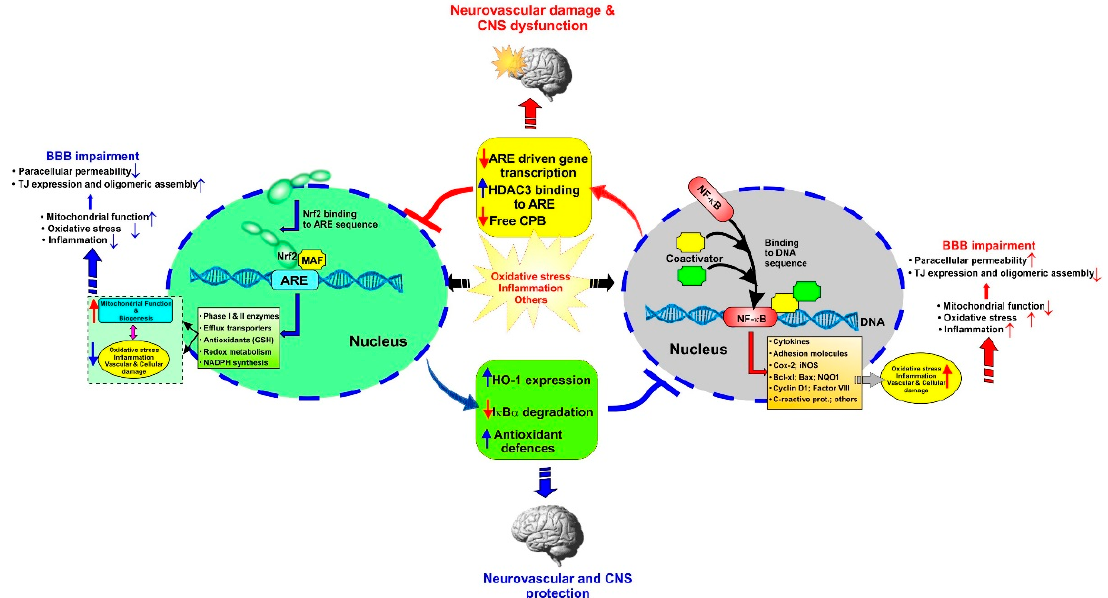
Figure 1. Schematic representation of the NRF2–NF-kB cross talk with respect to oxidative stress and inflammatory stimuli. Note that an “up arrow” indicates upregulation while a “down arrow” indicates downregulation